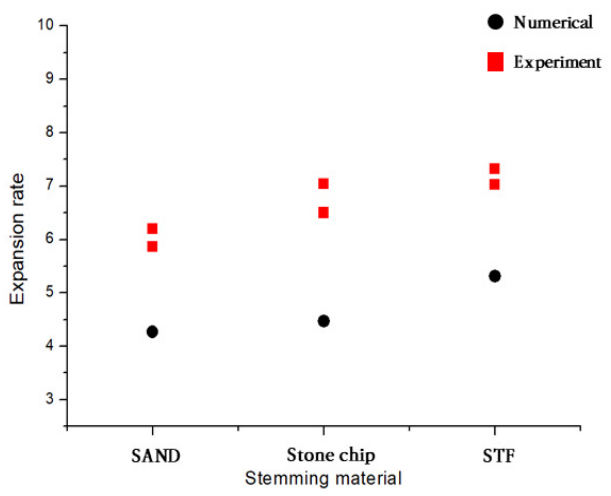
Figure 20. Comparison results graph of the Trauzl test and numerical analysis.